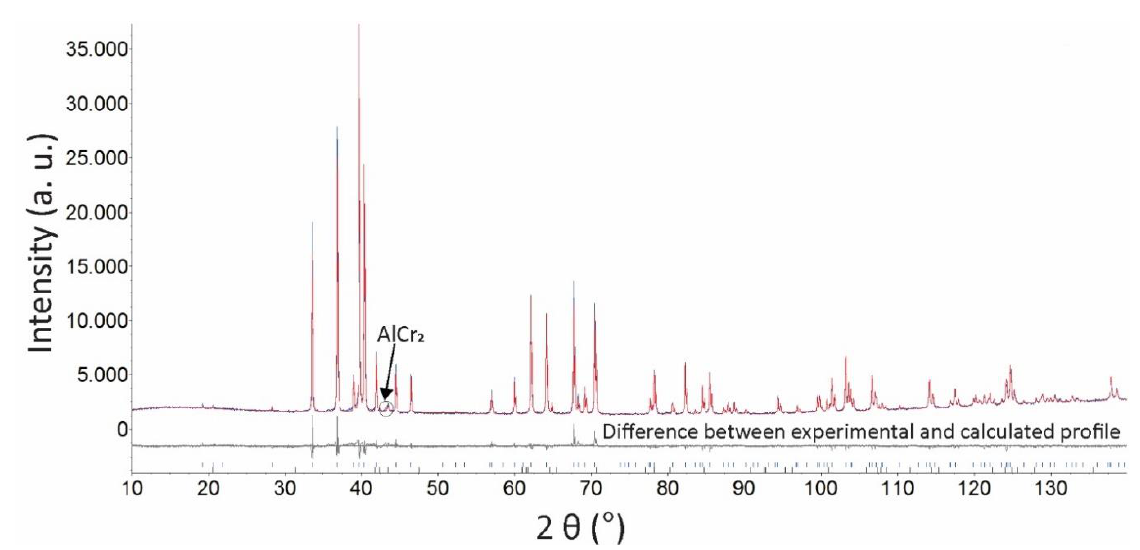
Figure 5. Rietveld plot of the annealed sample III . The experimentally measured PXRD pattern is shown with a blue line, while the calculated pattern is in red. The difference between the calculated and experimentally determined patterns is presented in grey. The final reliability factor was Rwp = 4.18%.